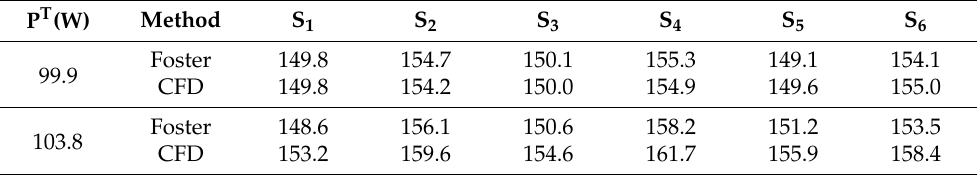
Table 2. Comparison of steady-state junction temperatures in the CFD analysis and Foster network (unit: ◦